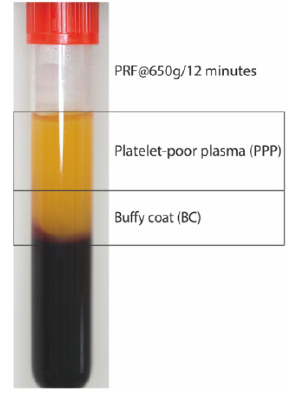
Figure 9. PRF prepared at 650 g in a horizontal centrifuge. The yellow PRF clot was compressed between two layers of dry gauze. Either the total PRF membrane or the PRF membrane being cut into two pieces representing the buffy coat (BC) and the platelet-poor plasma (PPP) was used to prepare the